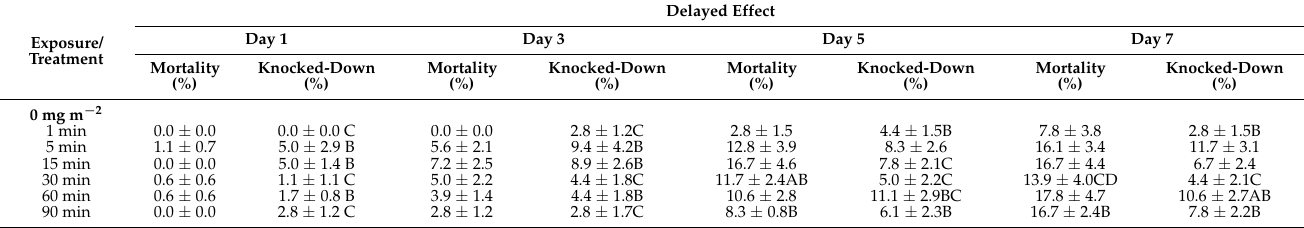
Table 2. Mean mortality and knock-down effect (% ± SE) of Lasioderma serricorne adults exposed for 1, 5, 15, 30, 60, 90, 120, and 240 min and 12 and 24 h to nets with different concentrations of alpha-cypermethrin (0, 10, 30, 80, 163.5, and 325mg m − 2 ) evaluated 1, 3, 5, and 7 d after exposure (delayed